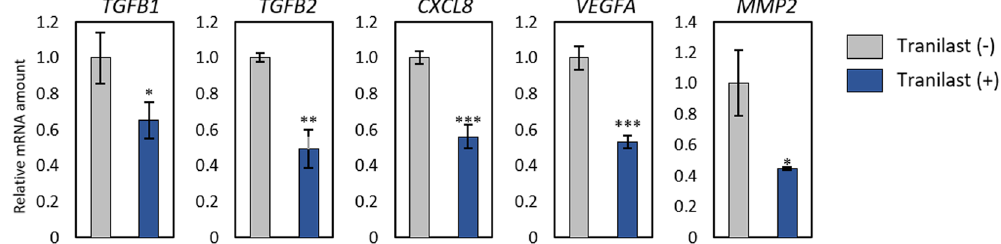
Figure 5. Tranilast suppresses the expression of angiogenesis-related genes in sNF96.2 cells. sNF96.2 cells that had been incubated in the absence or presence of tranilast (250 μ M) for 48 h were subjected to quantitative RT-PCR analysis of TGF- β 1, TGF- β 2, IL-8 (CXCL8), VEGF-A, and MMP2 mRNAs. Data are means ± s.d. for triplicates from a representative experiment. * P < 0.05, ** P < 0.01, *** P < 0.001 versus corresponding control value (Student’s unpaired t